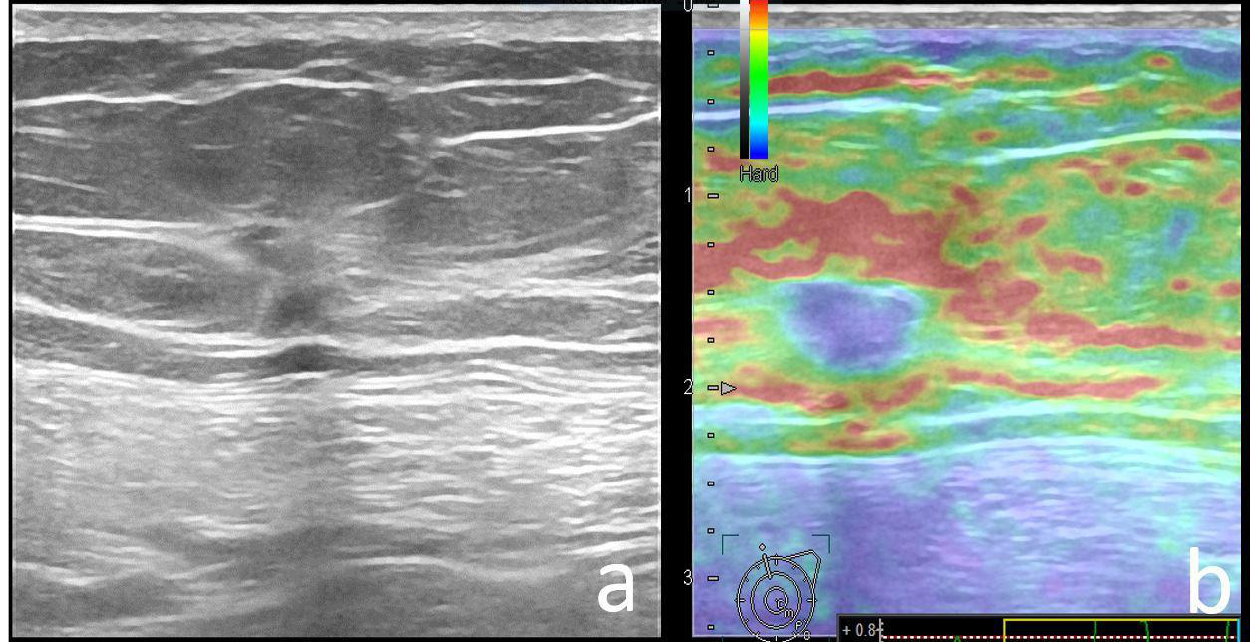
Figure 2. 60-year-old BRCA2 mutation carrier patient with left breast cancer. There is an irregular, slightly hypoechoic mass with indistinct margins and non-parallel orientation compared to the skin ( a ), with a hard elastography appearance (TSUKUBA score 5, b ). Pathology: IDC-NST, ER/PR-positive, HER2-negative, grade 2, ki67 = 25%.